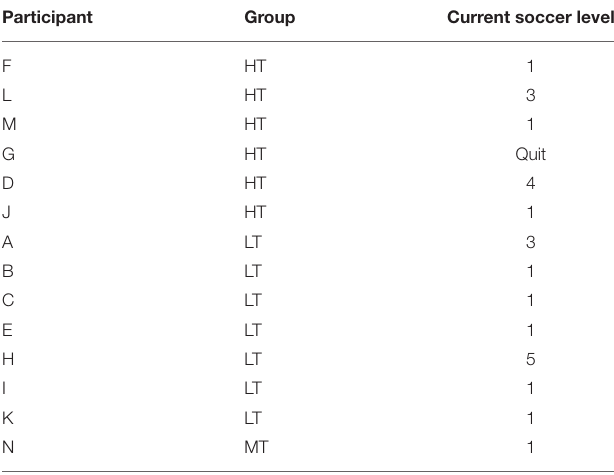
TABLE 4 | Current soccer level 2019/2020.